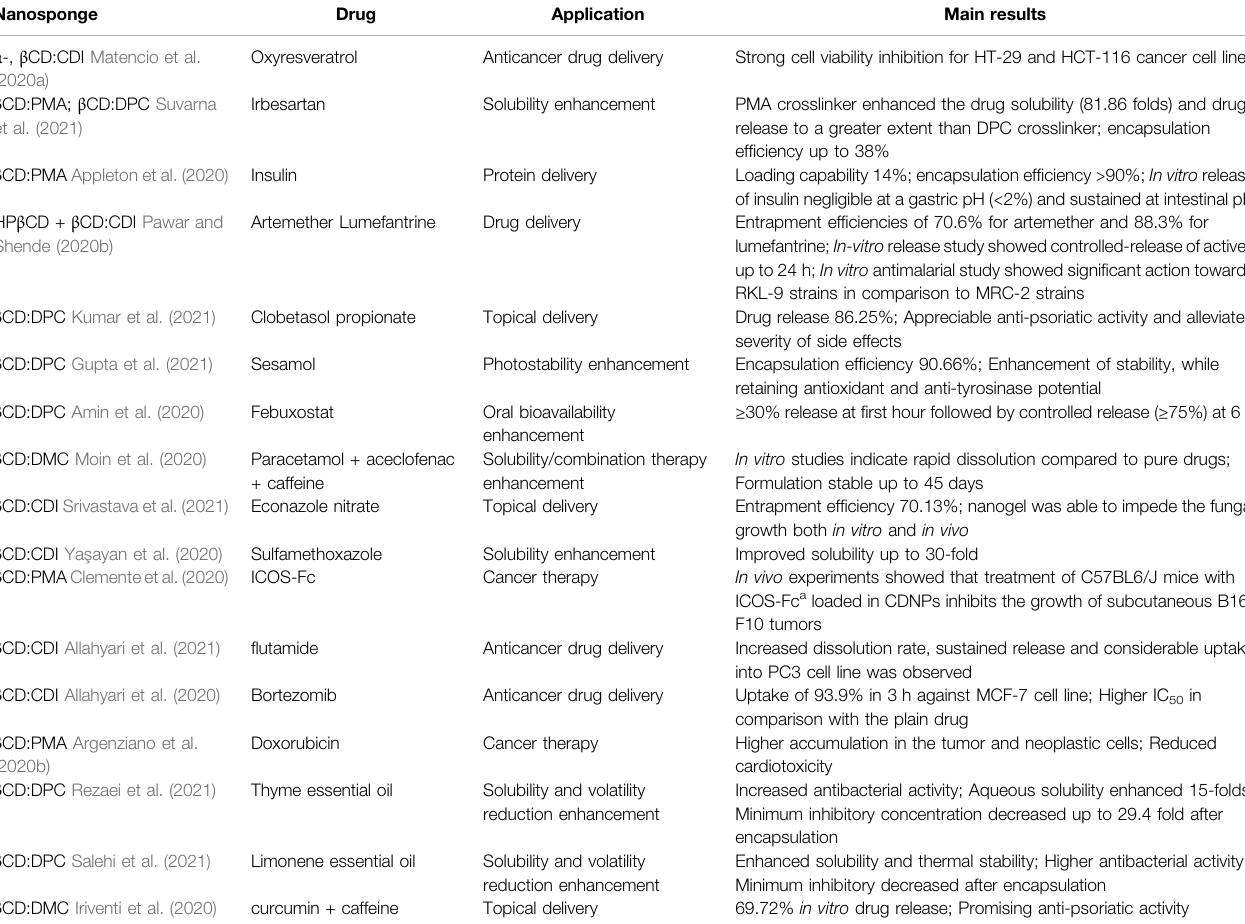
TABLE 3 | Some recent examples (2020 – 2021) of fi rst generation CDNSs applications in pharmaceuticals.